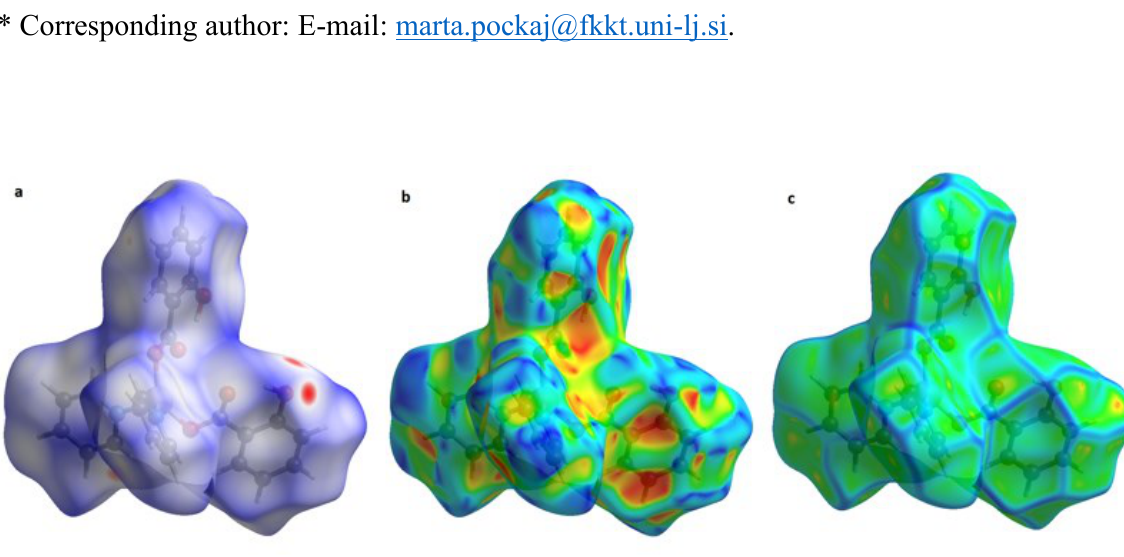
in the range from −0.17 7 to norm